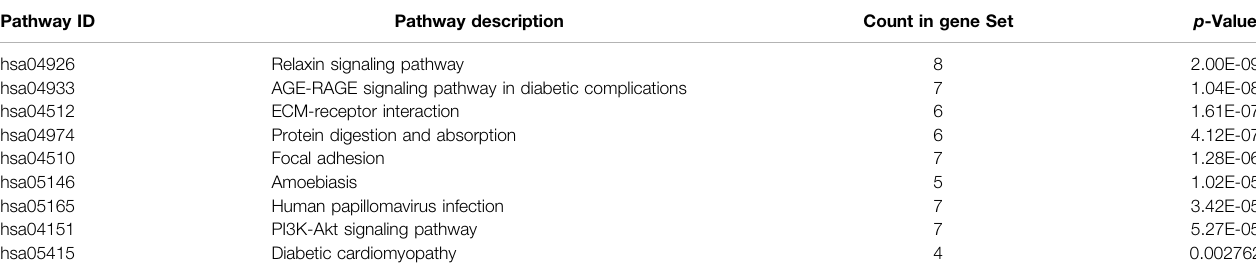
TABLE 2 | KEGG analysis for m6A Signature gene-B. Pathway